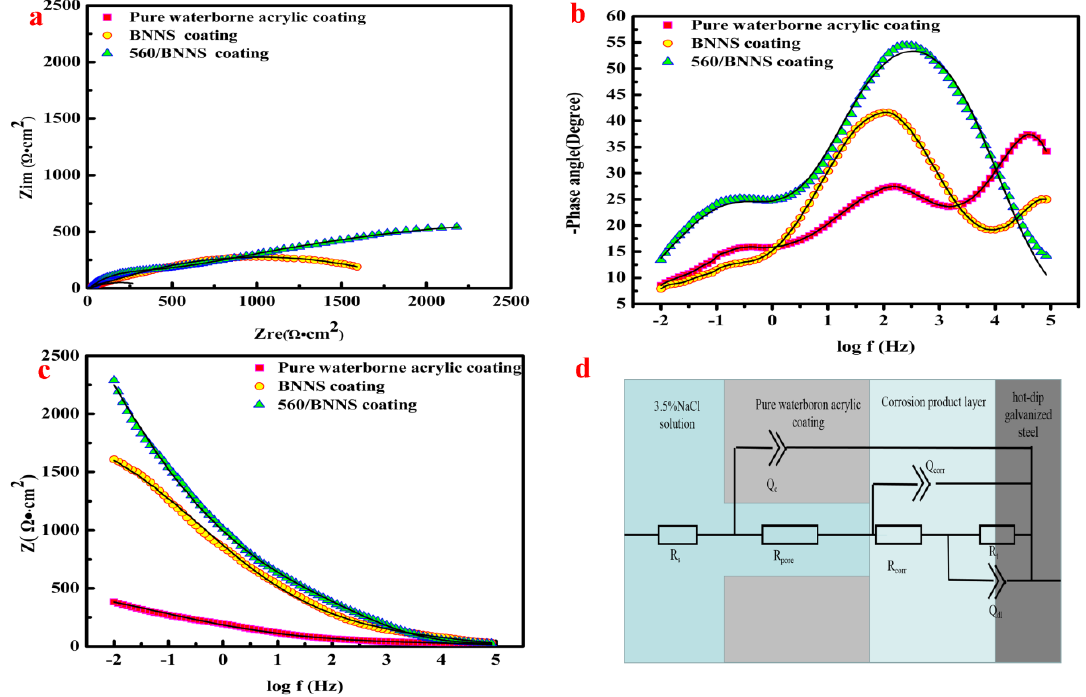
Figure 11. The EIS results of pure waterborne acrylic coating, BNNS coating and 560/BNNS coating after long-term immersion. ( a ) is the Nyquist plot, ( b ) and ( c ) are the Bode plots, ( d ) is the equivalent electric circuit.